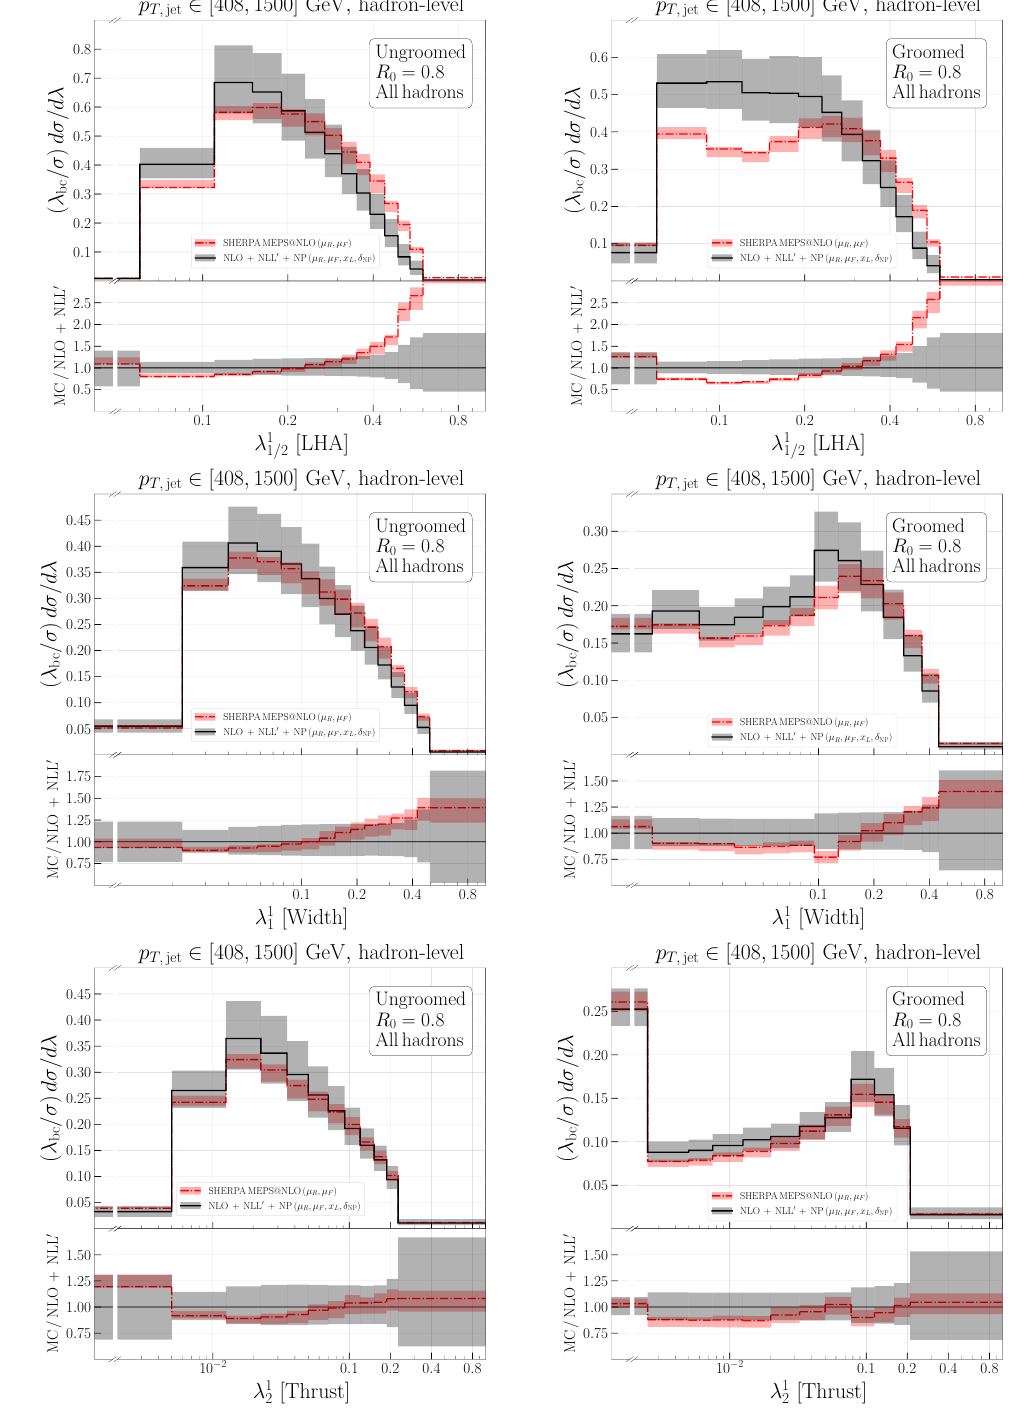
Figure 14 . Comparison of hadron-level predictions from S HERPA (MEPS@NLO), based on all final state hadrons, for ungroomed and groomed jet-angularities in Zj production, with p T, jet ∈ [408 , 1500] GeV, with NLO + NLL 0 results corrected for non-perturbative effects. Here λ bc stands for the bin